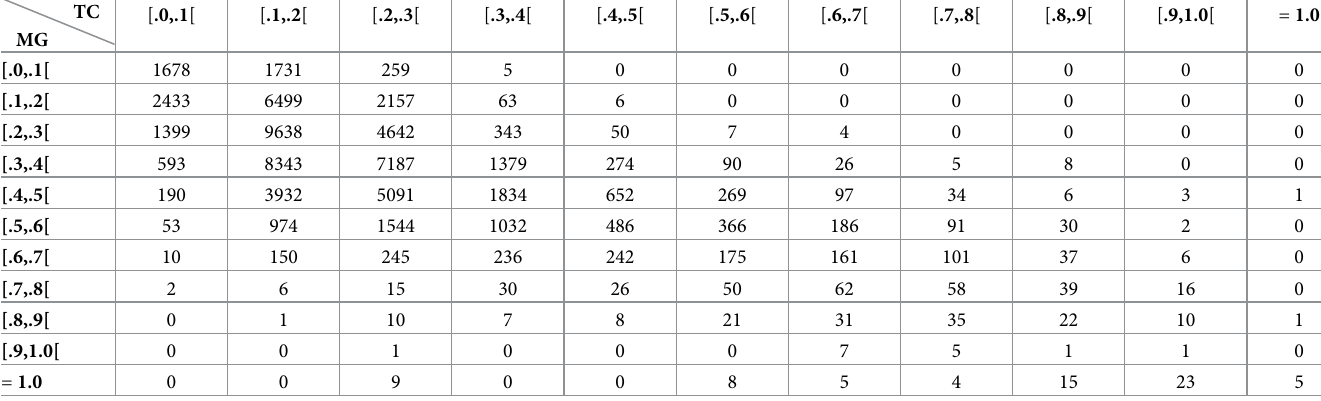
Table 3. Confusion matrices of MG and TC. MG